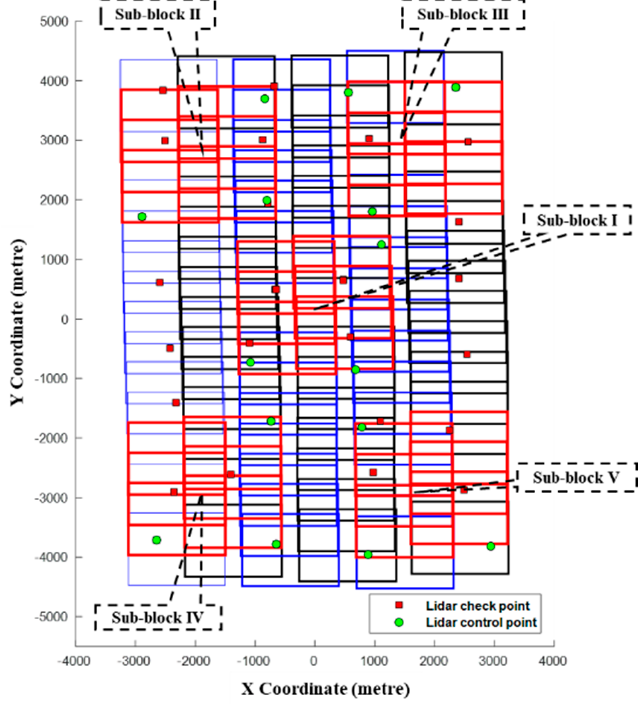
Figure 1. Layout of the entire image block, five sub-blocks locations (red lines) and spatial distribution of the Lidar control points (LCPs).